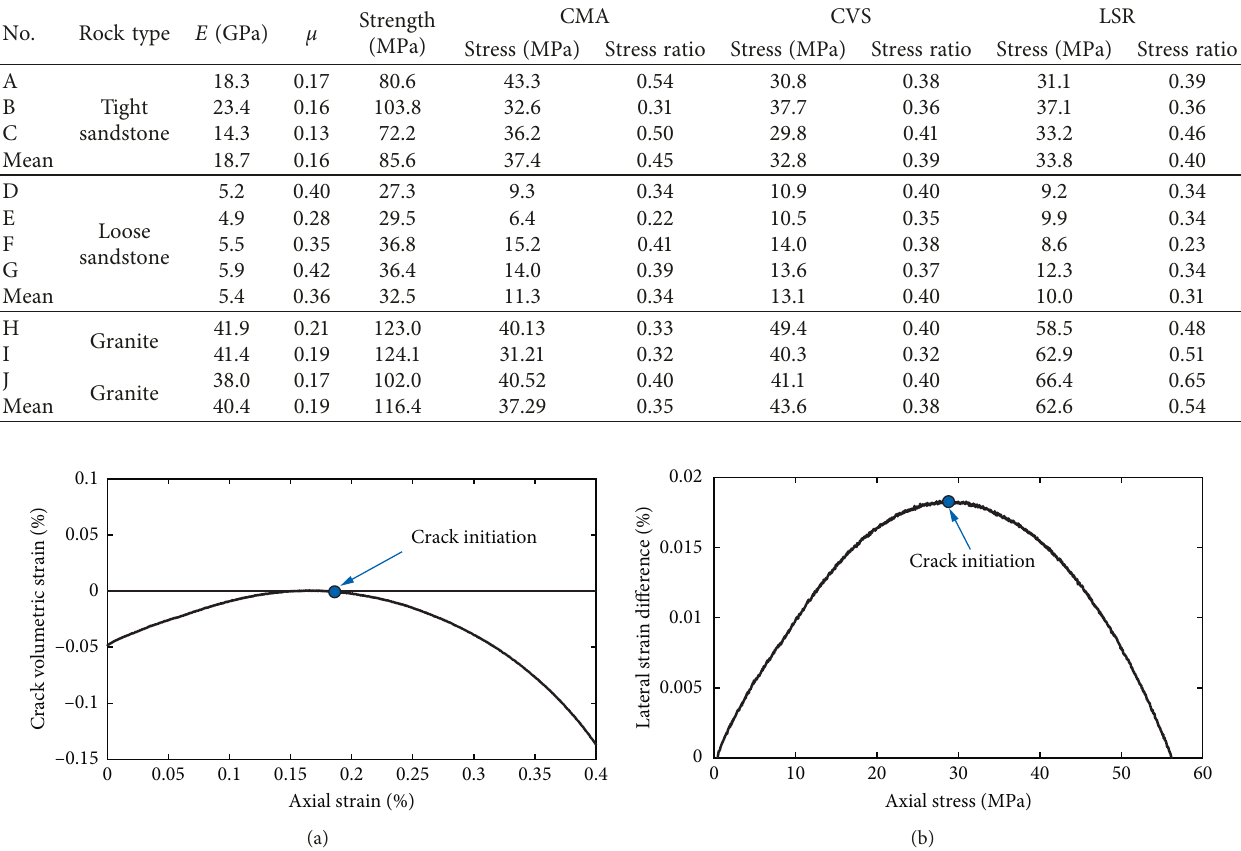
Table 2: Comparisons of the results used for determining the crack initiation stress.